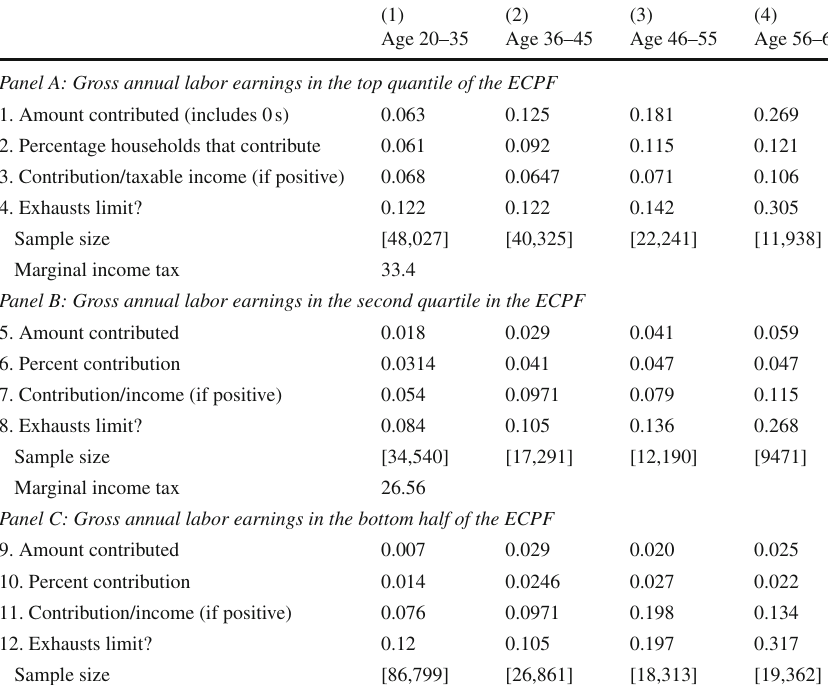
Panel C: Gross annual labor earnings in the bottom half of the